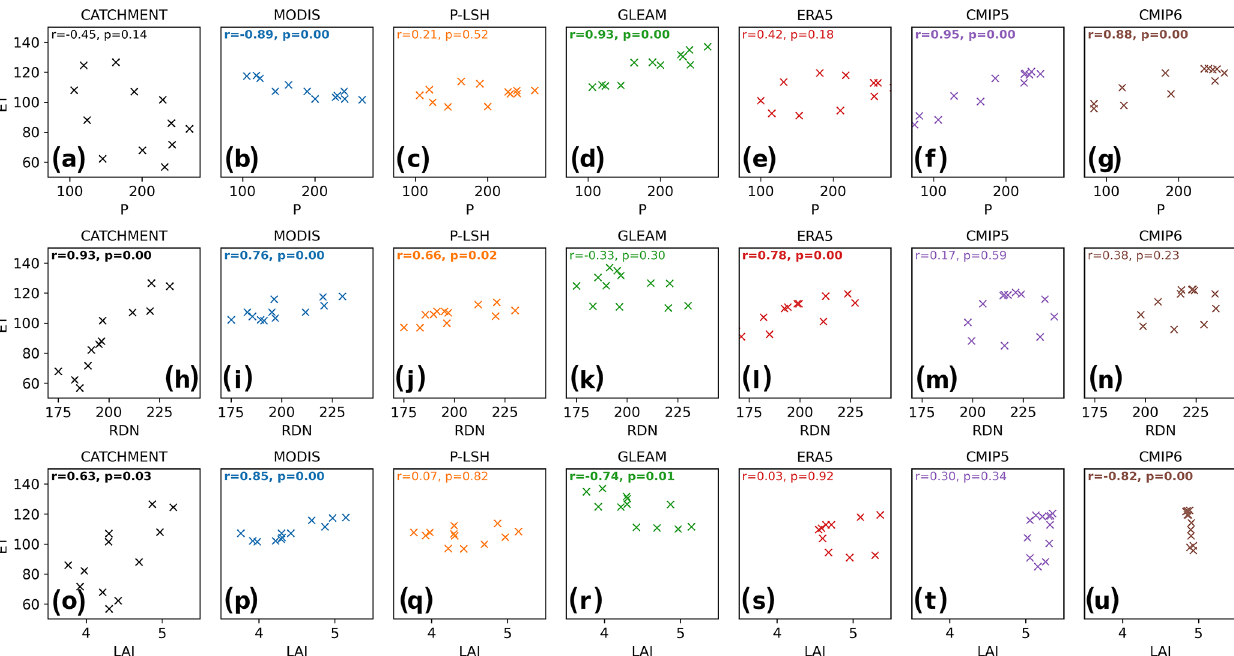
Figure 7. Controls on seasonal variation in Amazon evapotranspiration (ET). Monthly ET (in units of millimetres per month) for the Amazon region drained by Óbidos (see Fig. 1) from catchment balance, satellites (MODIS, P-LSH, and GLEAM), ERA5 reanalysis, and climate mod- els (CMIP5 and CMIP6) plotted against (a–g) precipitation ( P , millimetres per month), (h–n) surface shortwave radiation (RDN, Wm − 2 ), and (o–u) leaf area index (LAI, m 2 m − 2 ). Satellite ET data are plotted against P from CHIRPS, RDN from CLARA-A1, and LAI from MODIS; ERA5 and climate model ET are plotted against ERA5 and model P , RDN, and LAI respectively. Data are from 2003 to 2013 with the exception of CMIP5, for which data are from 1994 to 2004. Note that the axes do not start at